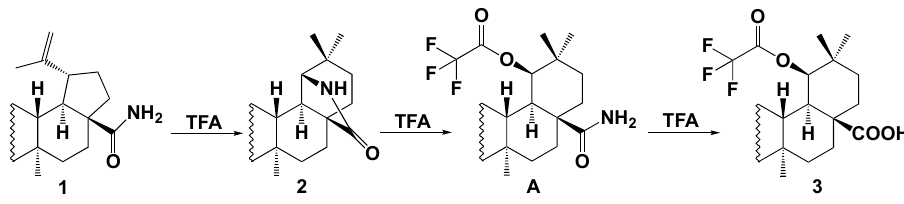
Figure 2. Plausible way of rearrangement of compound 1 to compounds 2 and 3.